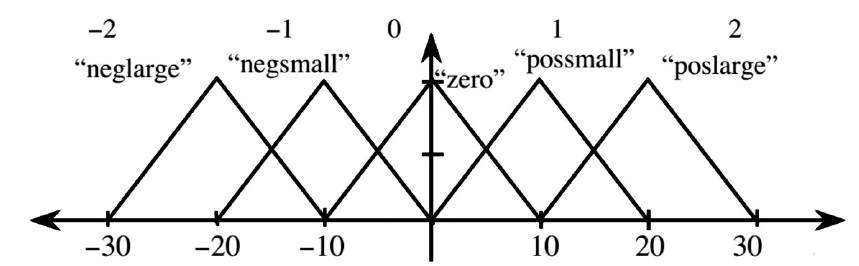
Figure 7. The fuzzy sets for k i . Table 1. The fuzzy rule base.